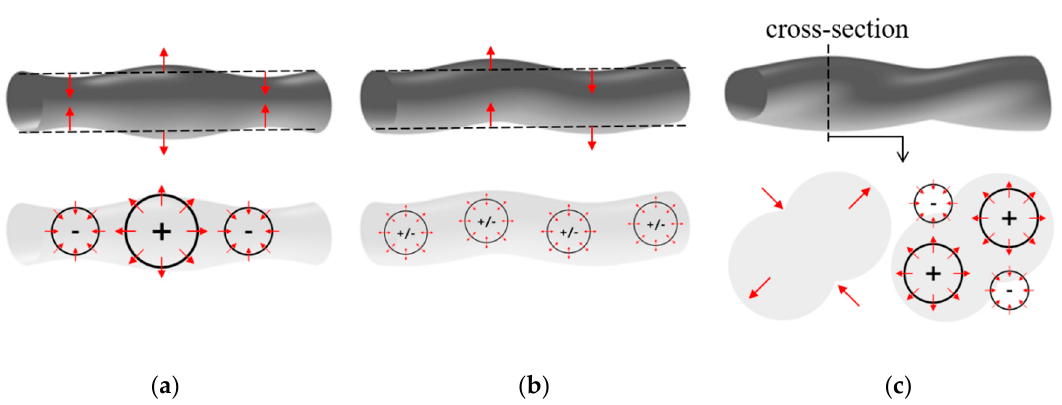
Figure 26. Comparison of wing-tip vortex cavitation shape and PSD between experiment and bubble dynamics simulations at t = 0.0999 s; ( a ) N = 1721 ea; ( b ) N = 2869 ea; ( c ) N = 4303 ea; ( d ) N = 8606 ea; ( e ) N = 17,212 ea.